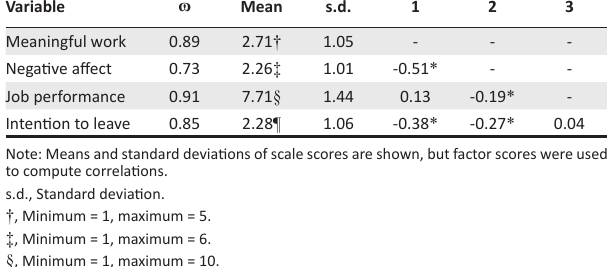
TABLE 3: Descriptive statistics, reliabilities and Pearson correlations of the functionings. Variable ɷ Mean s.d. 1